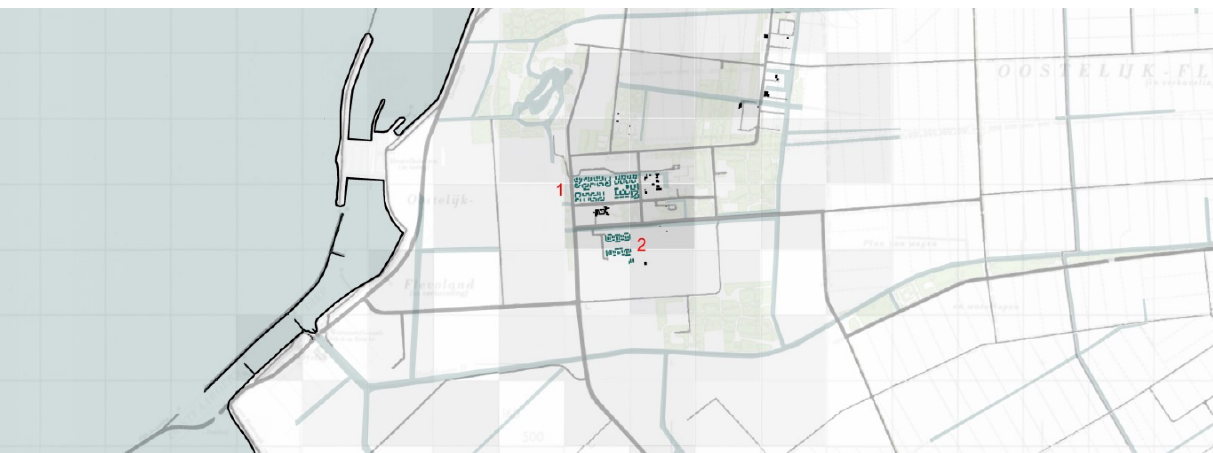
Figure 12. Neighbourhoods that had been built in 1970. Notes: (1) Zuiderzeewijk (phase 1) and (2) Atolwijk (phase 1). Source: authors.